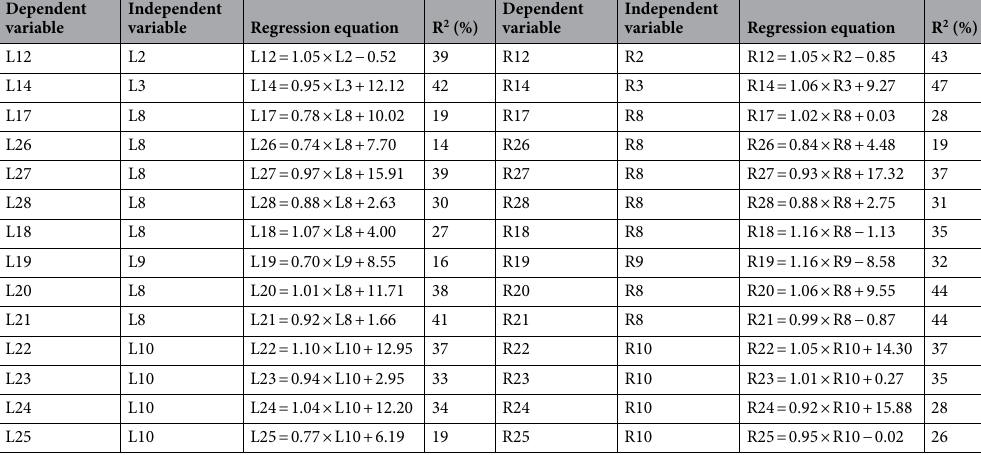
Table 1. Regression equations developed from the measurements in males. The coefficient of determination is R 2 . All regression equations are shown in Supplementary Table S3. ‘L’ stands for left, and ‘R’ stands for right in each